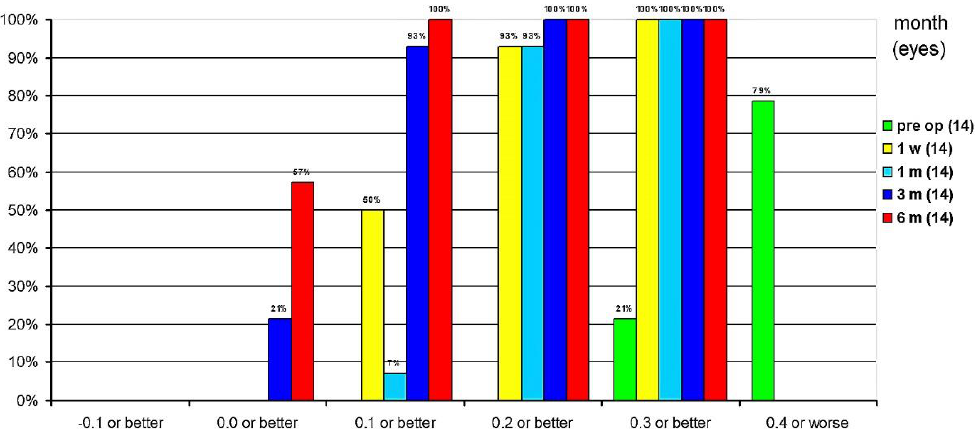
Figure 7. Cumulative uncorrected distance visual acuity.